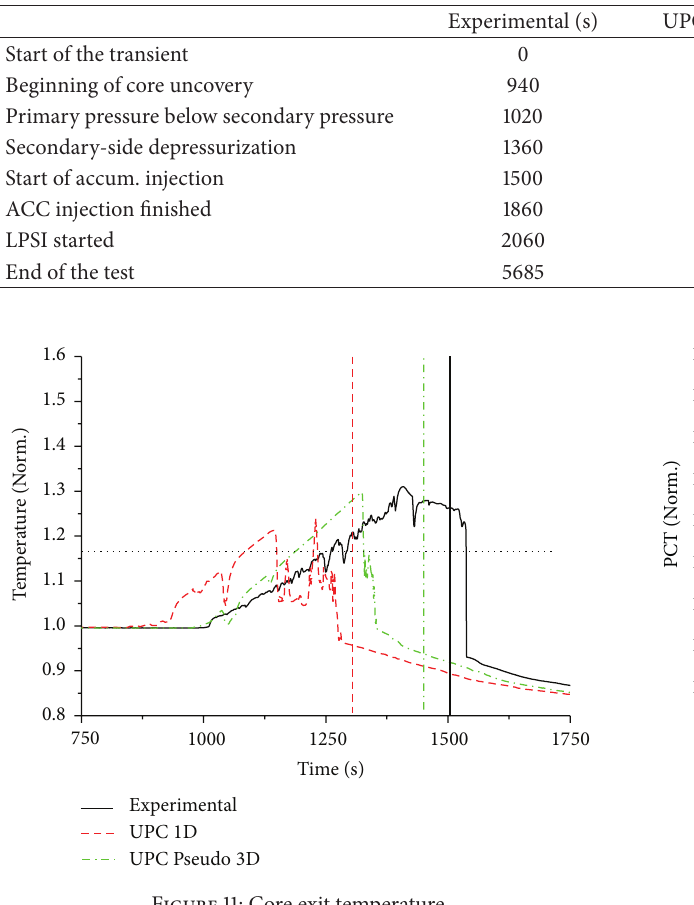
Table 4: Main events of PKL G7.1 Test.